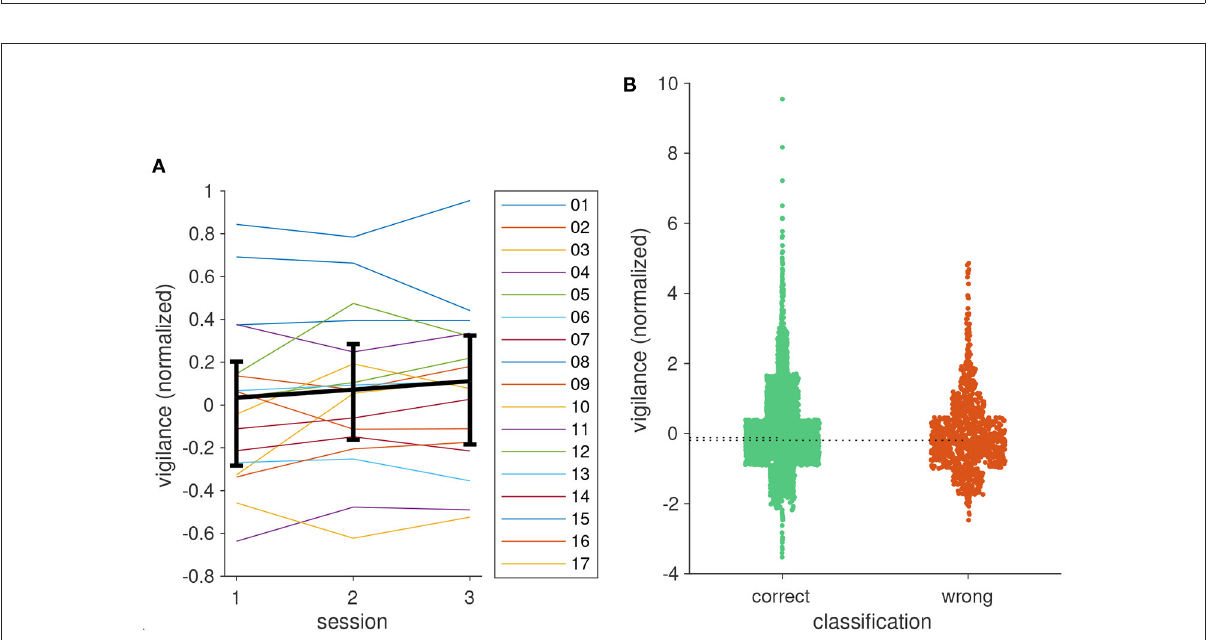
FIGURE10 (A) Median vigilance levels for the three sessions. Error bars show the 25 and 75% quantiles. (B) Distribution of vigilance values for trials with correct and incorrect classification results. Width of a scatter block corresponds to the number of samples in the interval marked by its height. Dotted lines indicate medians of the two